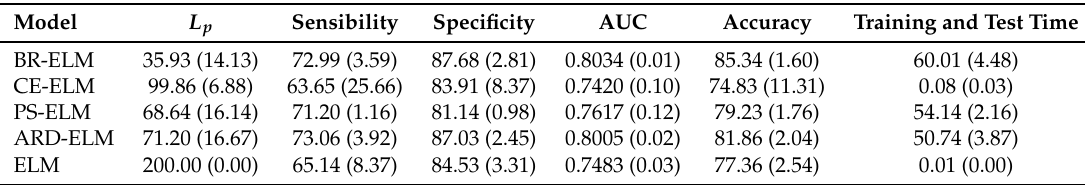
Table 14. Objectivity or subjectivity of sporting